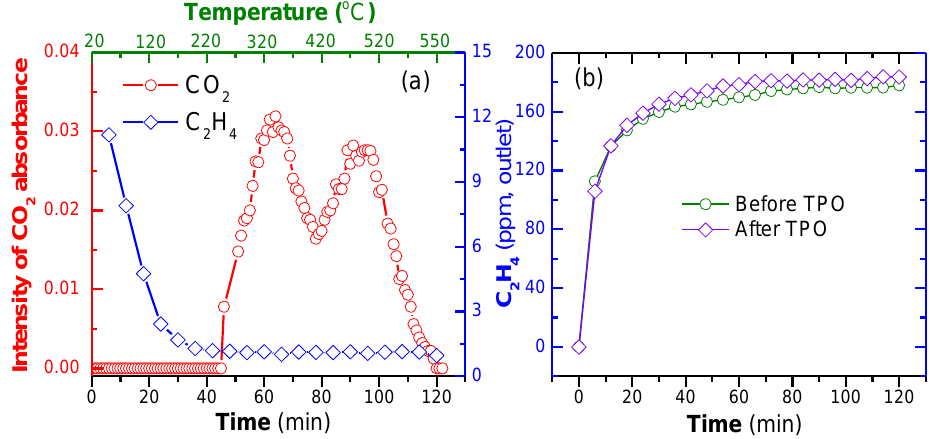
Figure 2. ( a ) TPO (temperature programmed oxidation) of C 2 H 4 and ( b ) C 2 H 4 adsorption of the catalyst before and after TPO (C 2 H 4 concentration: 200 ppm; Pd / ZSM-5: 5 g; feed gas flow rate: 2 L /